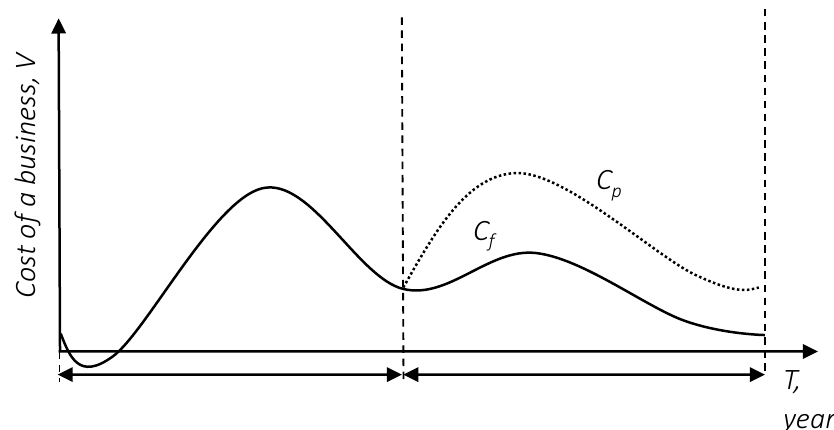
Figure 1. Change in the value of a business with an increase in the level of its information